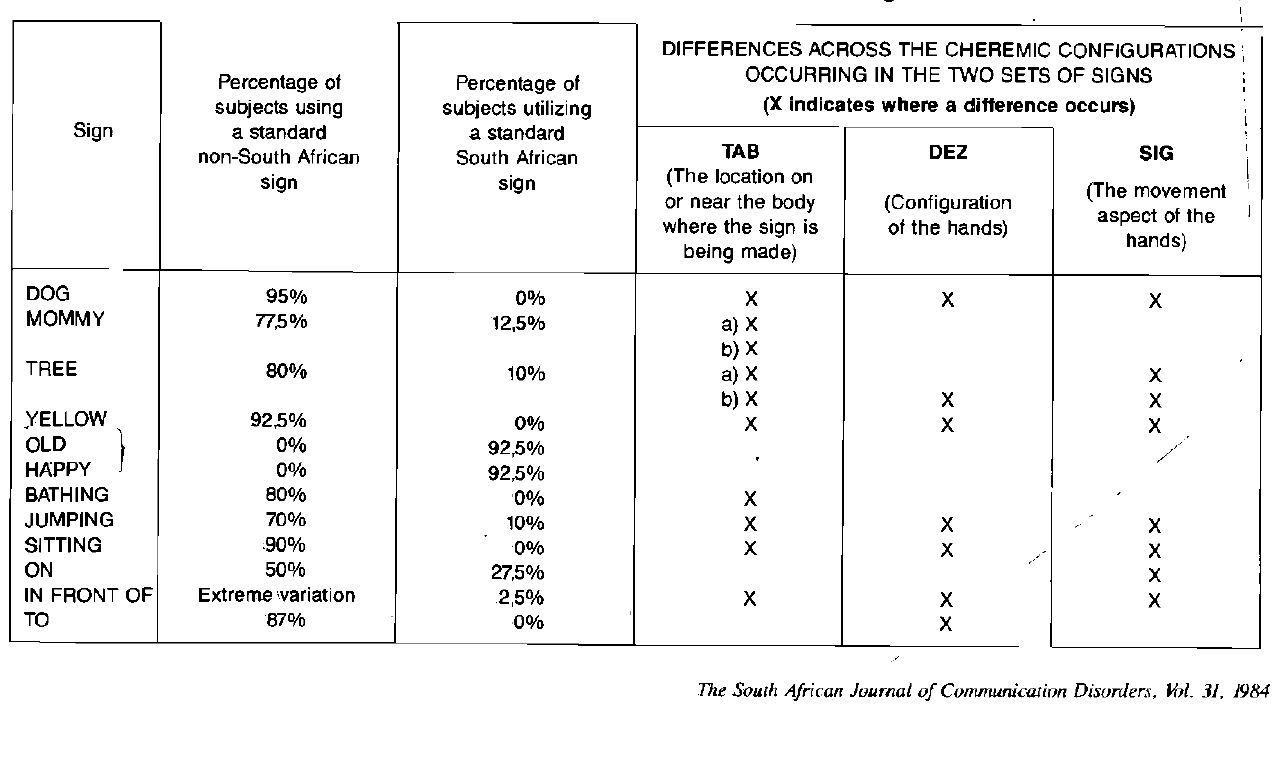
Table 1 Percentage of subjects using standard signs for the lexical items